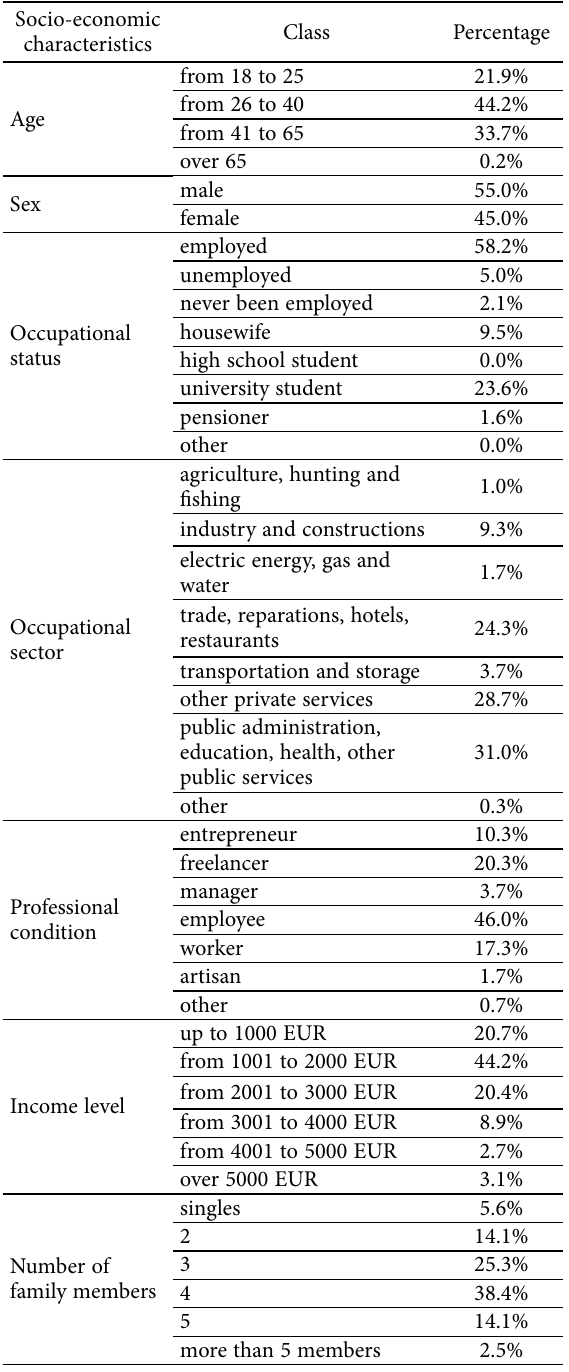
Table 1. Sample’s socio-economic